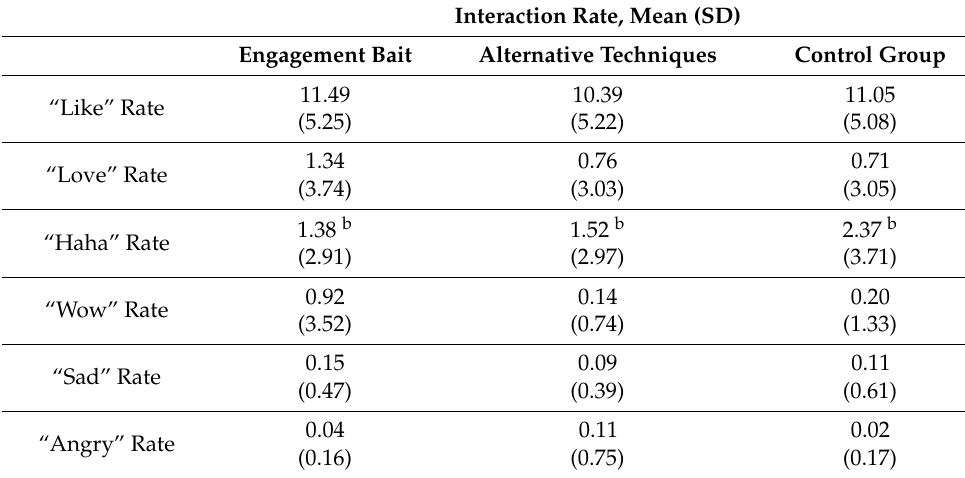
Table 2. The mean and the SD of interaction rate by engagement bait, alternative techniques, and the control